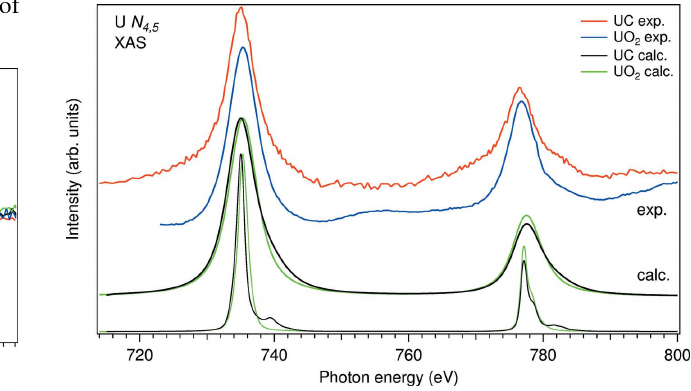
Figure 5 Calculated and measured U N 4,5 XAS spectra of UC and UO 2